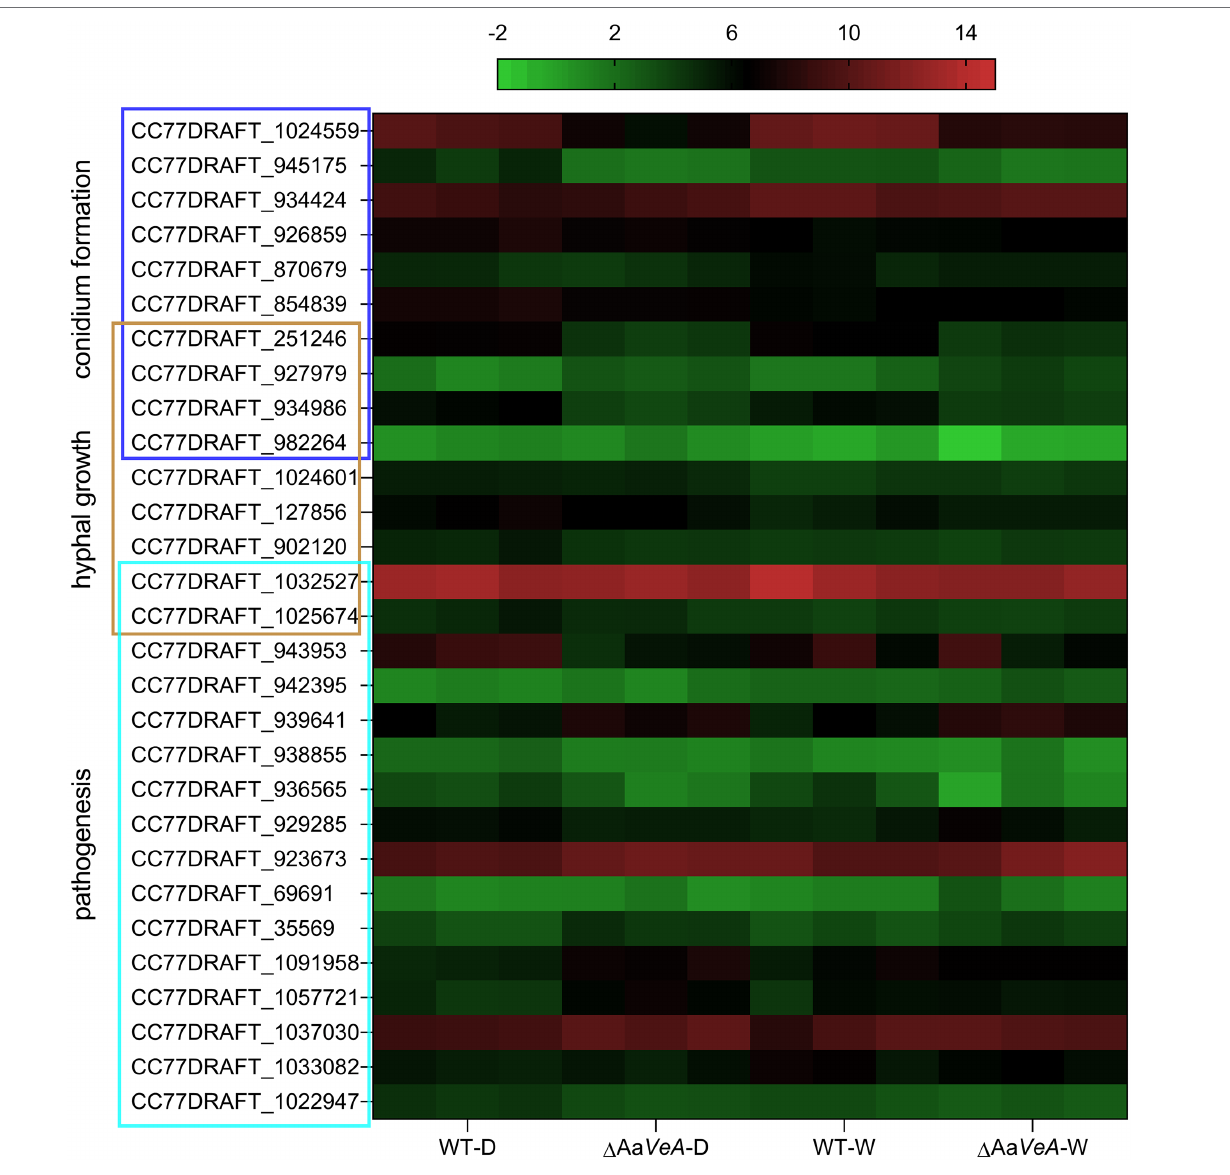
FIGURE 5 | The heat map of the transcriptional level of DEGs enriched in the biological process of hyphal growth, conidium formation, and pathogenesis. The transcriptional level of DEGs was expressed as the value of log 2 FPKM (Fragments Per Kilobase per Million) from the detailed transcriptomic